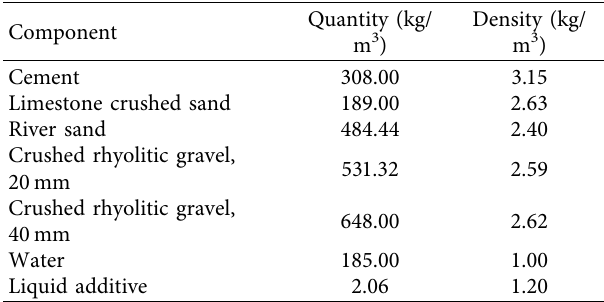
Figure 3: (a) Compressive strength test setup from the ASTM C39 standard. (b) Compression test setup from the ASTM C469 standard. (c) Bending test setup according to ASTM C78. Table 3: Summary of tested specimens. Table 4: Characteristics of the stage 2